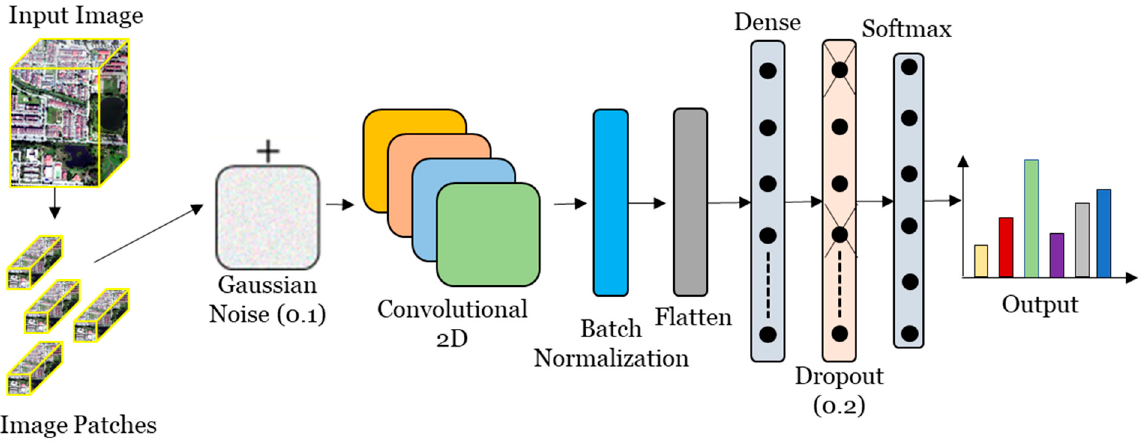
Figure 3. An illustration of the CNN architecture used in this study.